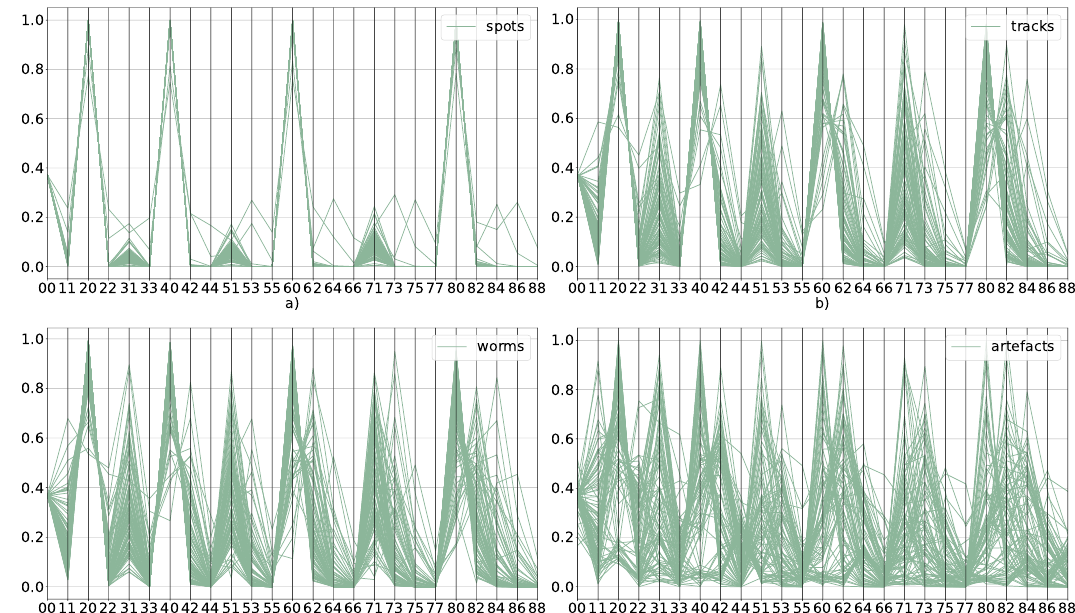
Figure 6. Parallel coordinate plots showing normalized values of Zernike moments for 95 examples of spots ( a ), tracks ( b ), worms ( c ) and artefacts ( d ). Numbers on the horizontal axes exhibit the n and m indices as per Equation